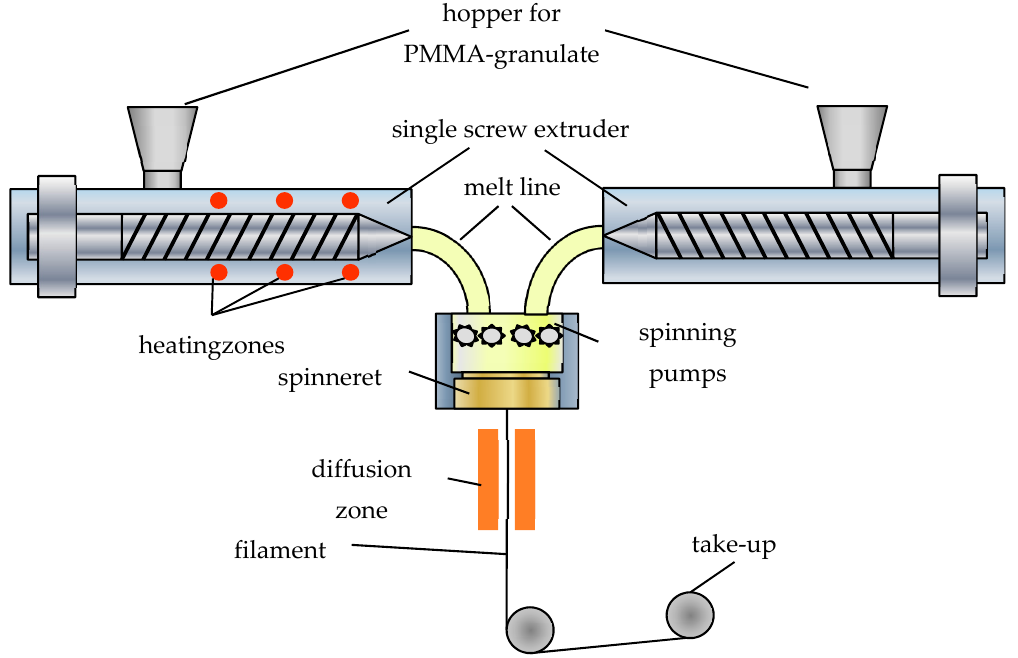
Figure 1. Example of a continuous POF fabrication process based on extrusion [5]. With this approach, only step-index fibers can be produced.